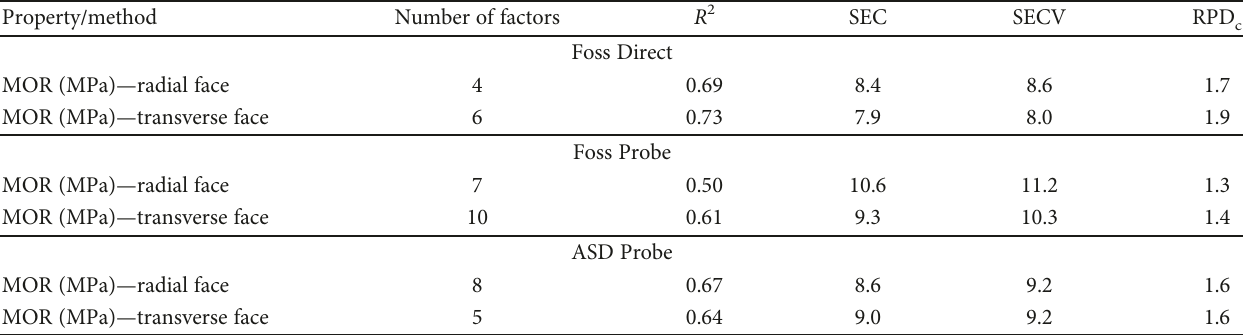
Table 7: Summary of modulus of rupture (MOR) based on radial and transverse face NIR spectra obtained using three di ff erent methods (Foss Direct, Foss Probe, and ASD Probe) for collecting spectral data. 334 samples were used to develop the calibrations.